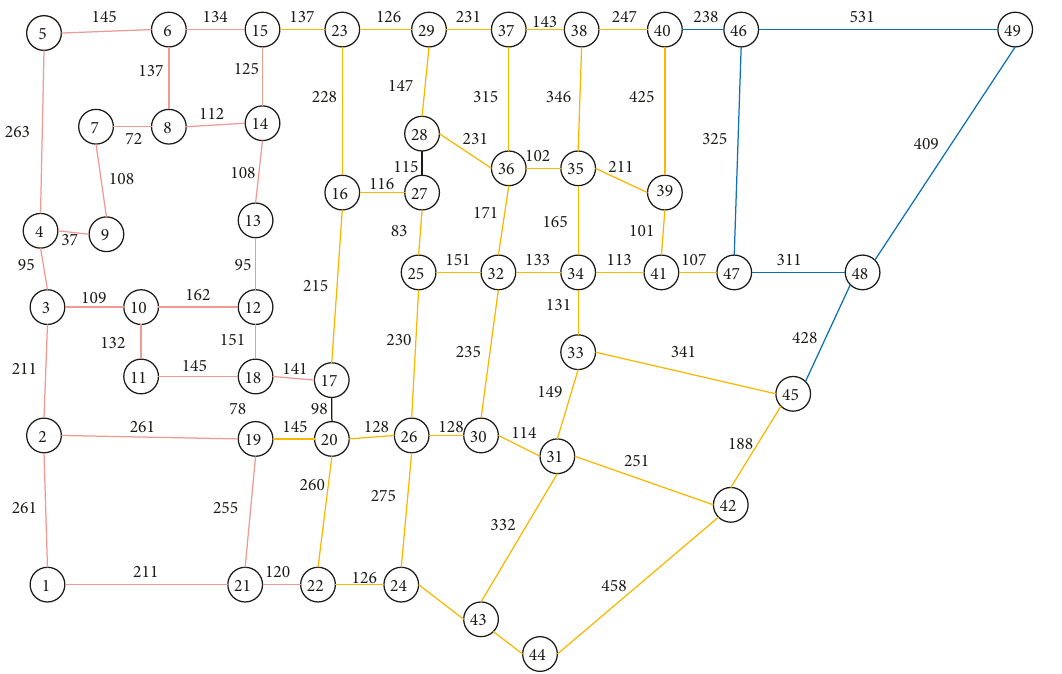
Figure 5: Road topology of a district in Lanzhou.